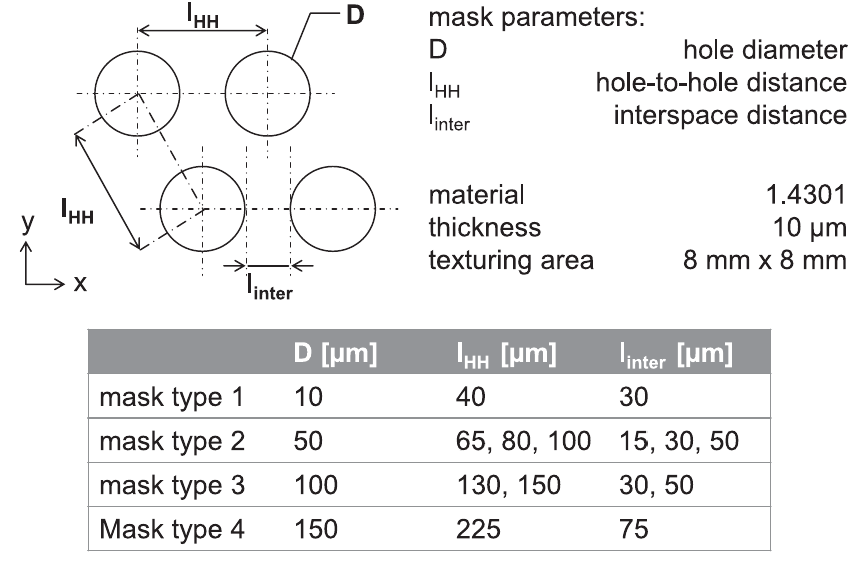
Fig. 1. Schematic illustration of the texturing parameters as well the applied mask con fi